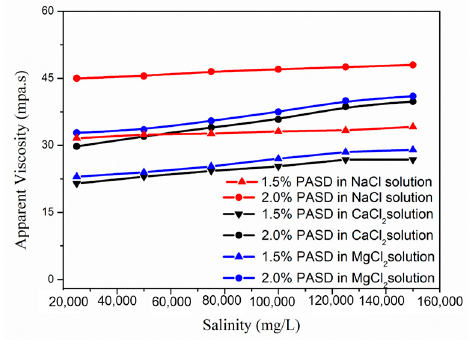
Figure 6. Effect of salinity concentration on apparent viscosity of PASD solution.